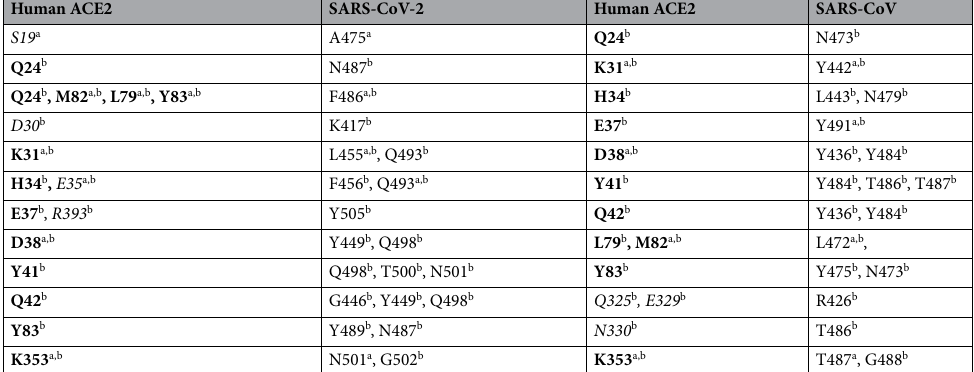
receptor and mammalian ACE2 receptors at key S protein-binding sites may provide crucial insights into the identification of mammals at high risk of SARS-CoV-2 infection. Human ACE2 receptors bind to S proteins on SARS-CoV and on SARS-CoV-2 with overall structural simi- larity; this is likely constrained by the structure of ACE2 2 . However, the S protein-coding genes are notably different between SARS-CoV and SARS-CoV-2 with about 75% homology 6,27 . This dissimilarity may contribute to a difference in viral infectivity and host range between the two SARS viruses. Indeed, based on two recent X-ray crystallography experiments 2,5 , different key residues on human ACE2 receptor are structurally involved in binding to S proteins of SARS-CoV-2 and SARS-CoV. Table 1 summarizes all experimentally identified site- specific interactions at the ACE2-S protein interface 2,5 . Four key human ACE2 sites bind to S protein of SARS- CoV-2 but they do not interact with S protein of SARS-CoV: ACE2 Ser19 forms a hydrogen bond with S protein Ala475, ACE2 Asp30 forms a hydrogen bond with S protein at Lys417, ACE2 Glu35 forms a hydrogen bond with S protein Gln493, and ACE2 Arg393 forms a hydrogen bond with S protein Tyr505. Furthermore, there are 11 other key human ACE2 sites (Gln24, Lys31, His34, Glu37, Asp38, Tyr41, Gln42, Leu79, Met82, Tyr83, and Lys353) that form either hydrogen bonds or salt bridges with S proteins of both SARS-CoV-2 and SARS- CoV, but they interact with different S protein residues. For example, ACE2 Gln24 forms a hydrogen bond with SARS-CoV-2 S protein at Leu472 but with SARS-CoV S protein at Asn473, and ACE2 Tyr41 forms a hydrogen bond with SARS-CoV-2 S protein at Thr500 and Asn501 but with SARS-CoV S protein at Thr486 and Thr487.